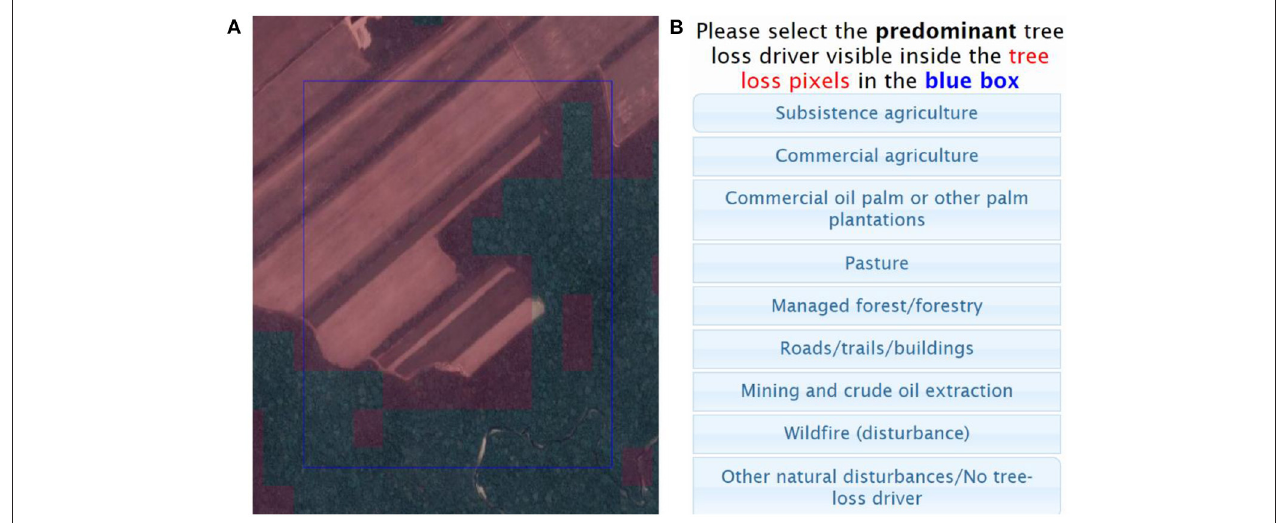
FIGURE 1 | Parts of the Geo-Wiki interface for the “Drivers of Tropical Forest Loss” crowdsourcing campaign showing (A) the 1km blue box for interpretation with Hansen’s global forest loss layer shown in red (Source: Google Maps, n.d.) and (B) the set of drivers for volunteers to select as predominant driver. For this sample location, the dominant driver is “commercial agriculture”.